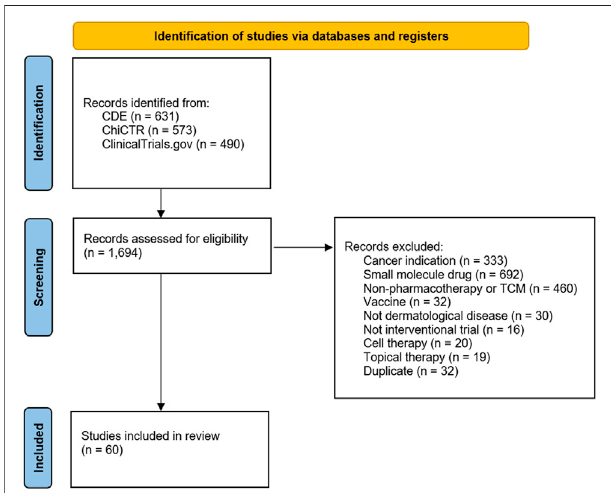
FIGURE 1 | PRISMA fl ow diagram.